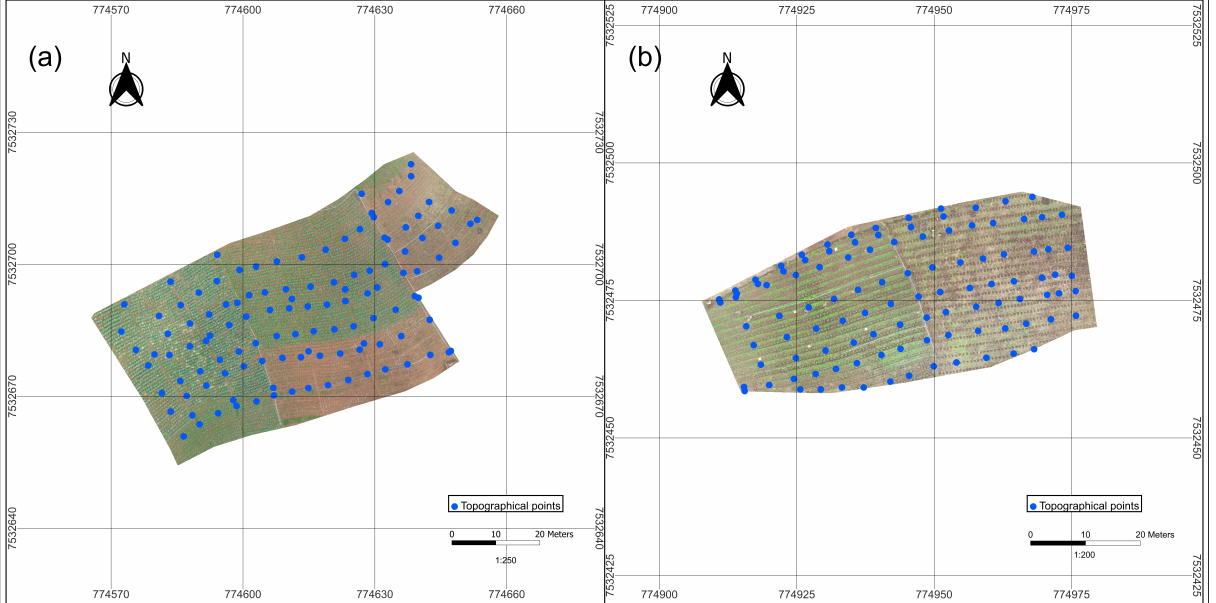
Figure 4. Surveyed points from the areas of Bom Jardim municipality: ( a ) location of points registered in area 1 by conventional topographic survey and ( b ) location of points registered in area 2 by the conventional topographic